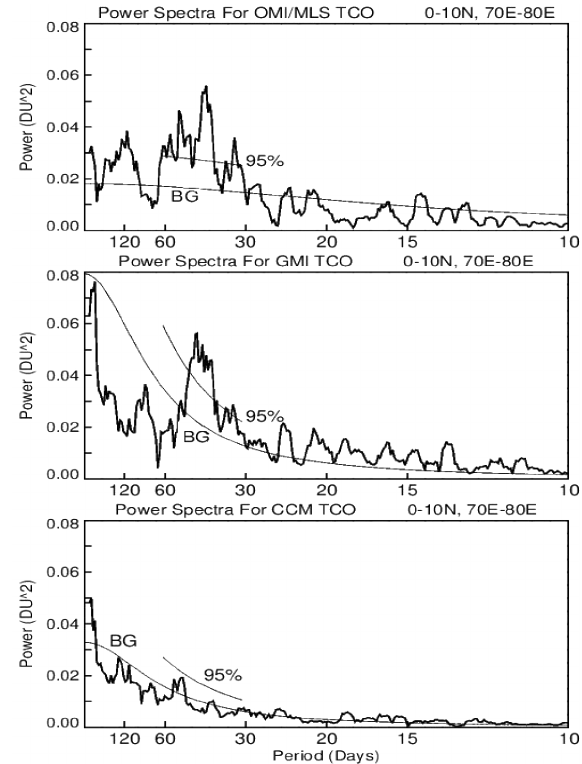
Figure 6. All three panels show calculated power spectra (in units of DU 2 ) of daily tropospheric column ozone time series averaged over a broad region of the tropical Indian Ocean (0–10 ◦ N, 70–80 ◦ E) where the MJO signal is statistically significant well above 95% for OMI/MLS and the CTM. The top, middle, and bottom panels are for OMI/MLS data, CTM output, and CCM output, respectively. The power spectra are plotted vs. frequency with periods in days shown. A power spectrum is defined by [ c(ω) 2 + s(ω) 2 ] / 2 where c and s denote derived Fourier cosine and sine coefficients, ω is circular fre- quency and the over-bar denotes application of a smoothed spectral estimator. Estimated background noise is denoted “BG” with 95% confidence level shown in each panel (see Appendix A for details of these